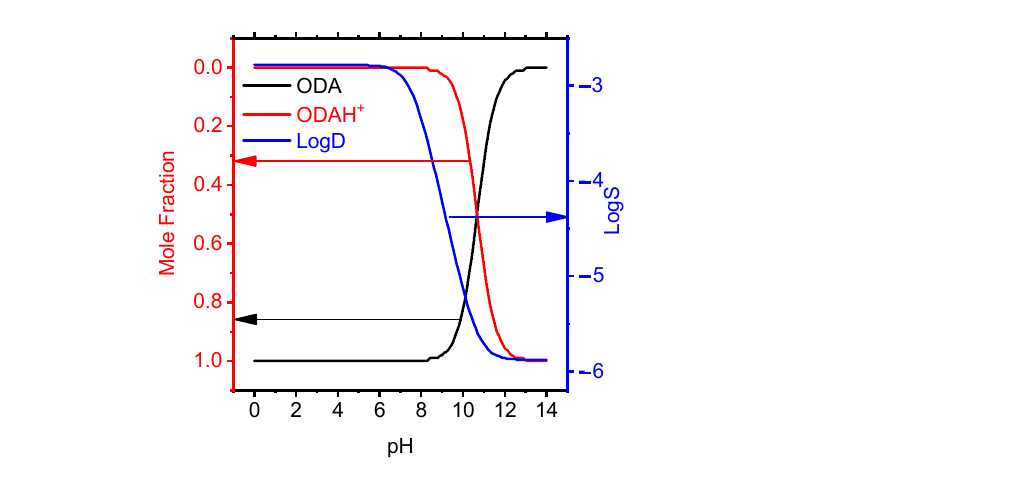
Figure 2. Effect of pH on the molar fraction of protonated ODA particles in aqueous solution and solubility.